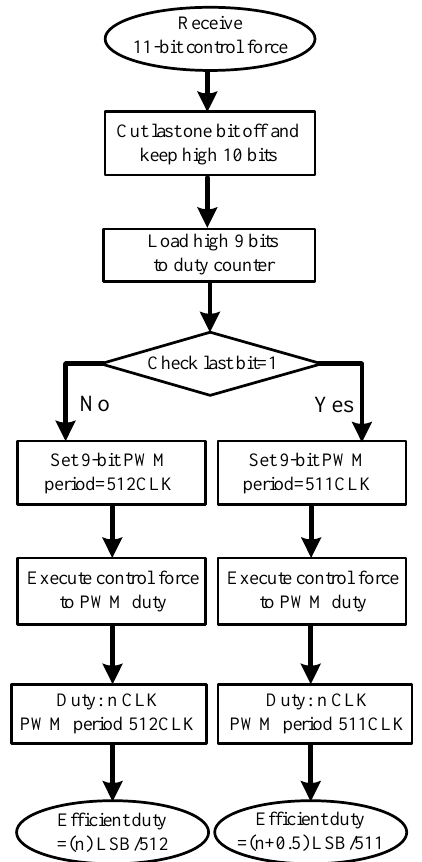
Figure 11. Program flow chart for the proposed PWFM strategy.